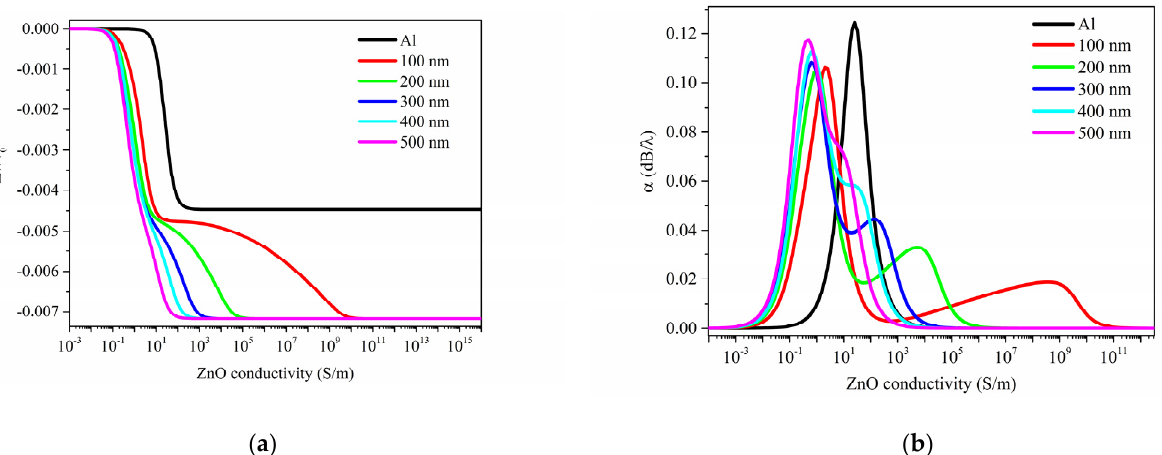
(cid:3415) and ( b ) propagation loss α vs. ZnO conductivity Figure 5. ( a ) Relative phase velocity change ∆𝑣 𝑣 Figure 5. ( a ) Relative phase velocity change ∆ v and ( b ) propagation loss α vs. ZnO conductivity (cid:2868) v 0 curves for different values of the UV penetration depth 𝛿 (cid:3046)(cid:3031) (from 100 to 500 nm). curves for different values of the UV penetration depth δ sd (from 100 to 500 nm).